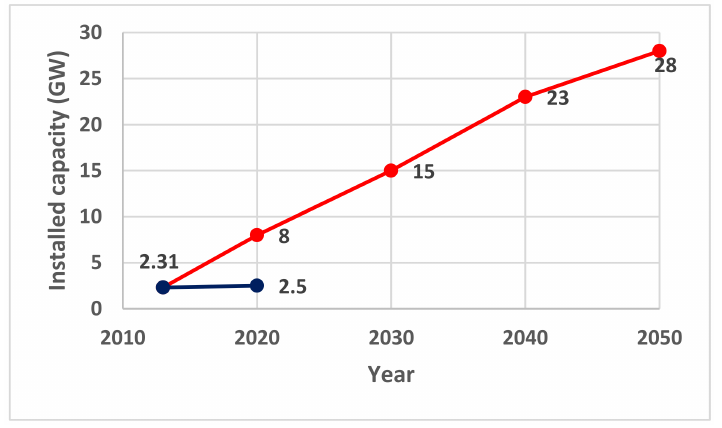
Figure 1. Forecast of installed capacity in GW for CSP projects in EU (red line) and current installed capacity in 2020 (in